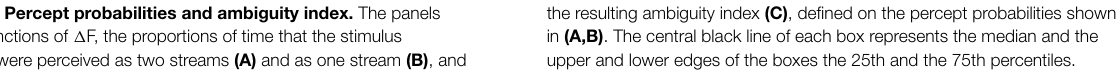
the resulting ambiguity index (C) , defined on the percept probabilities shown in (A,B) . The central black line of each box represents the median and the upper and lower edges of the boxes the 25th and the 75th